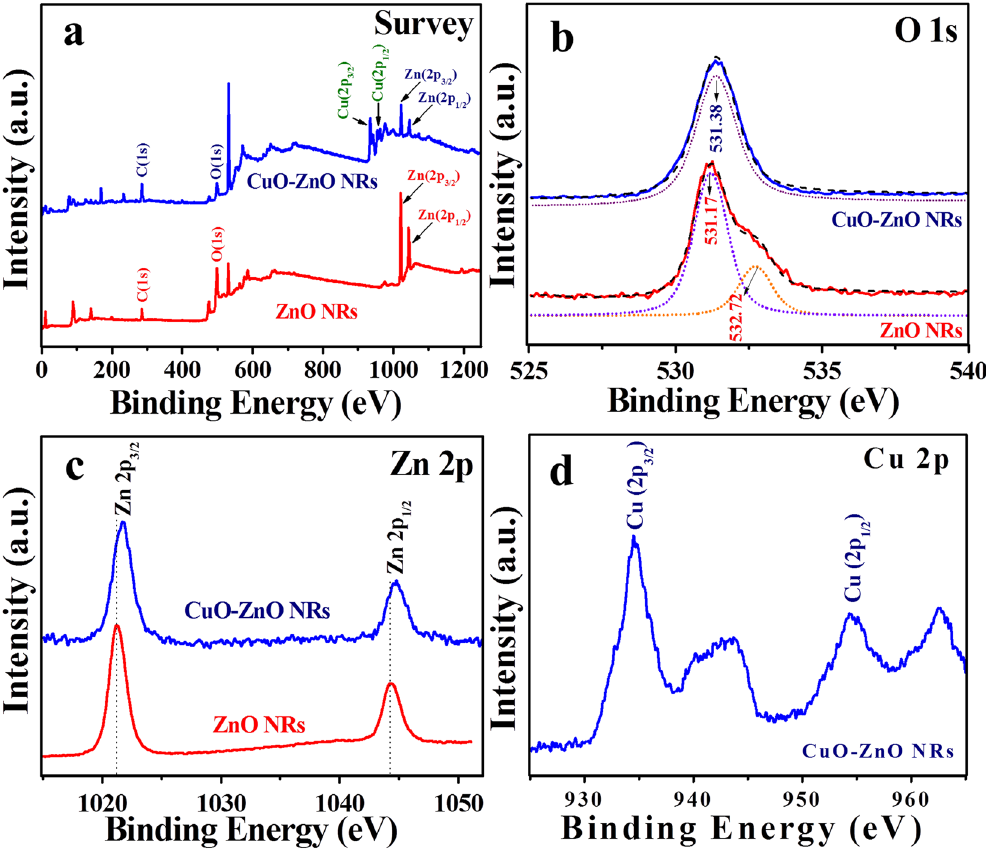
Figure 3. XPS analysis. XPS spectrum of ZnO NRs and CuO modified ZnO NRs showing full scan survey ( a ) and corresponding deconvoluted peaks in the high resolution spectra for O 1 s ( b ), Zn 2p ( c ), and Cu 2p ( d ) elements.